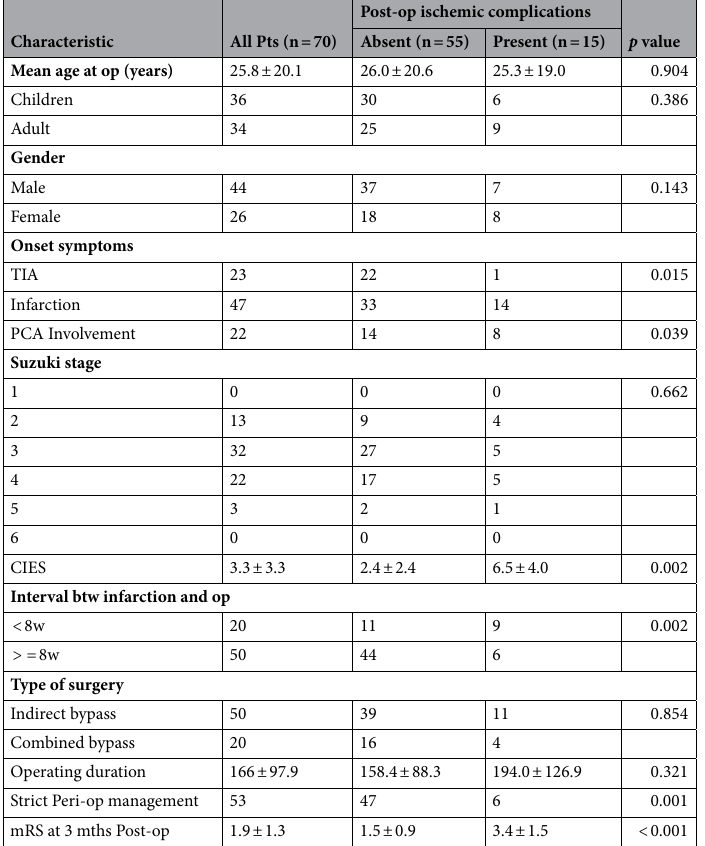
Table 2. Clinical characteristics of MMD patients. CIES cerebral infarction extent scoring system, Interval btw infarction and op Interval time between frequent TIA or infarction presentation and operation, mRS